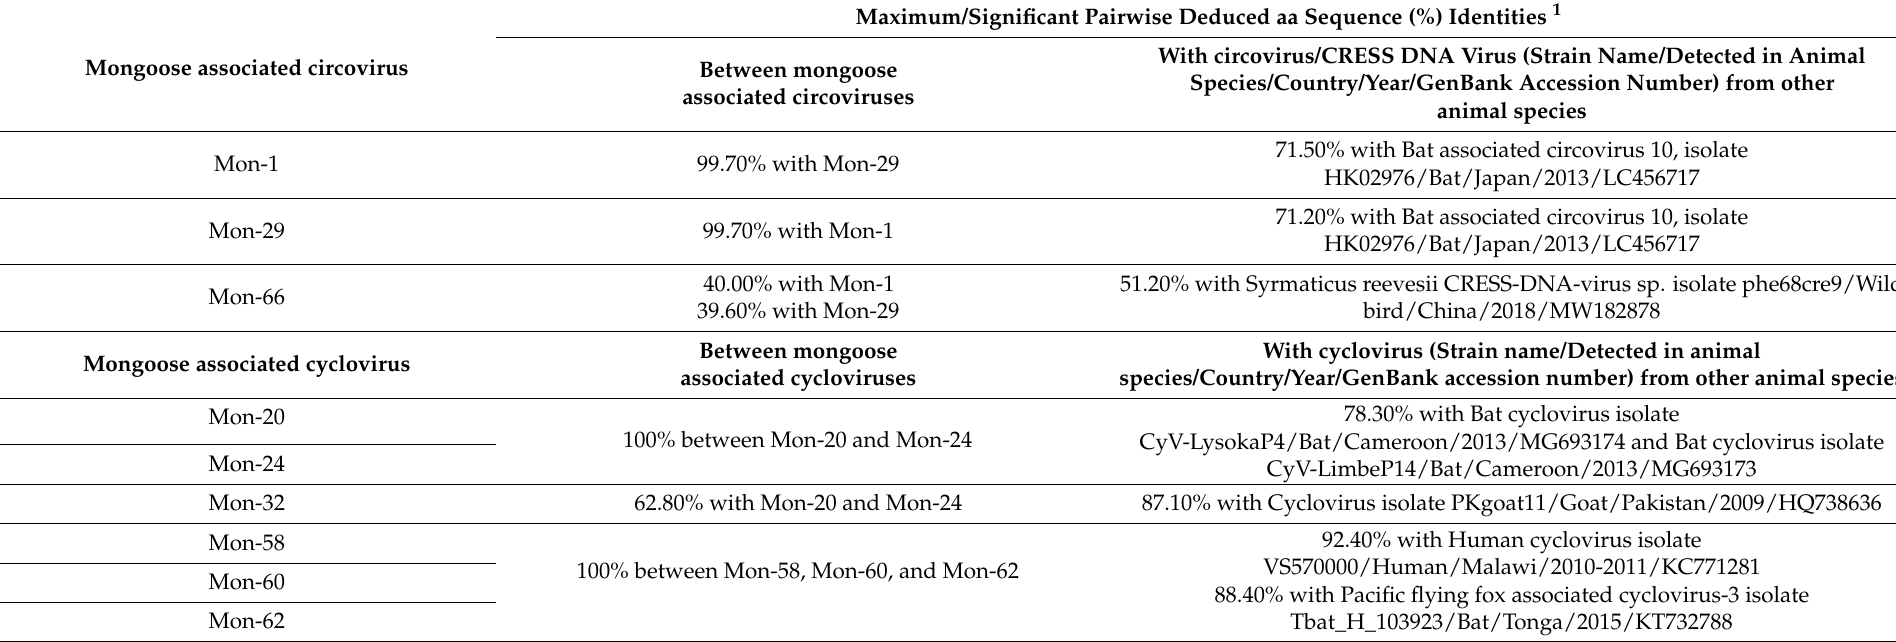
Table 3. Maximum deduced amino acid (aa) sequence identities of the putative replication associated proteins (Rep) of mongoose associated circoviruses and cycloviruses between themselves and with those from other animal